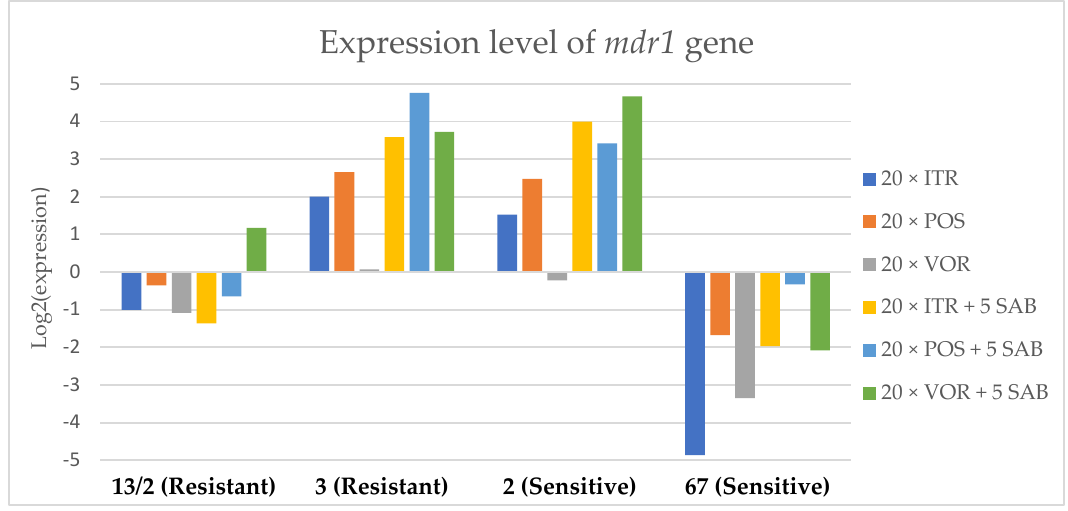
-5 Figure 5. Expression levels of mdr3 after culturing isolates on SAB with ITR, POS and VOR additions, followed by 5 times culturing on only SAB.